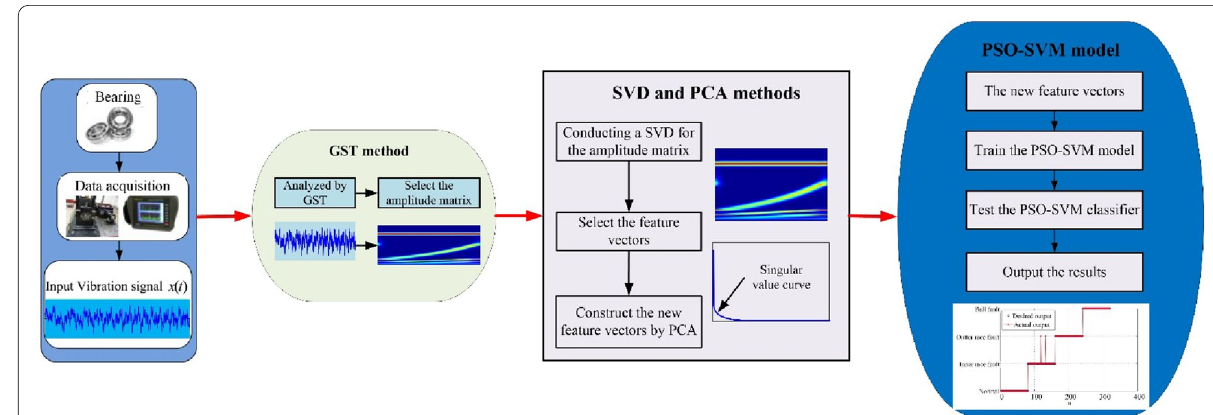
Figure 2 Framework of the proposed